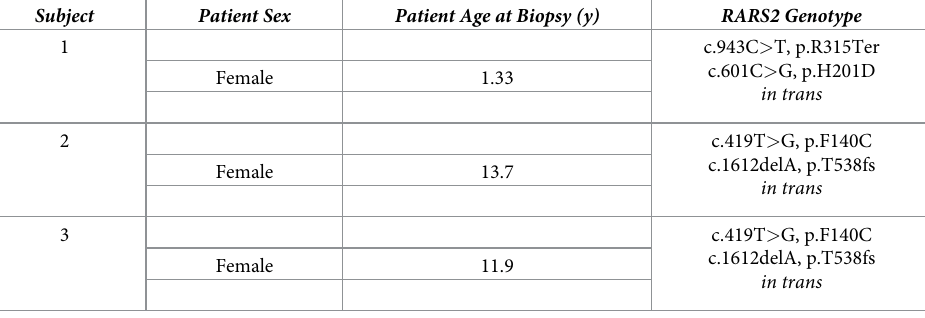
Table 1. PCH6 patient-derived fibroblasts